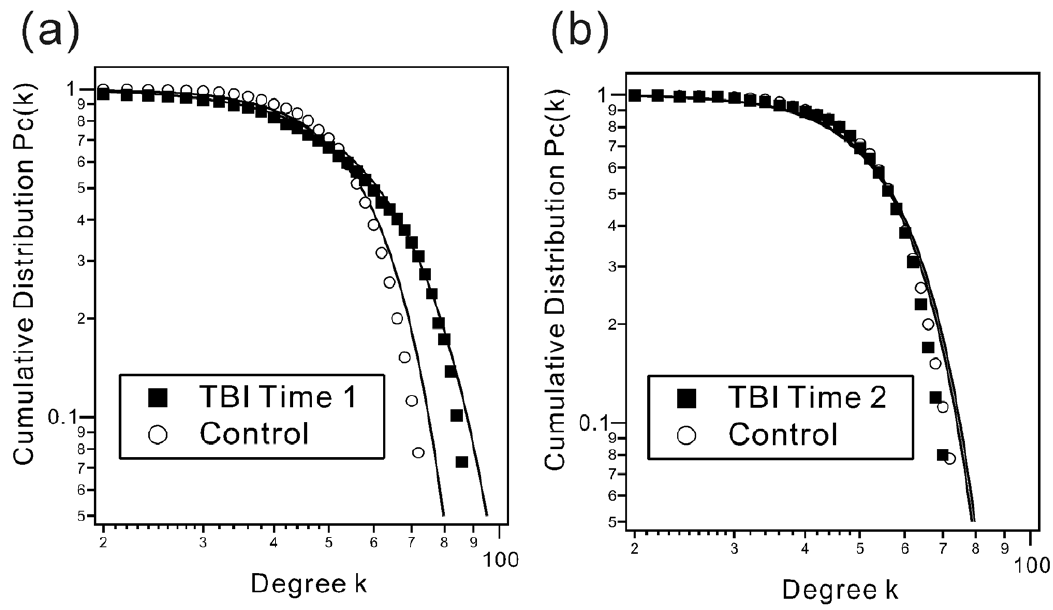
Figure 5. Cumulative degree distributions. The group averaged cumulative degree distributions P c ( k ) from (a) TBI at Time 1 and (b) Time 2 on double logarithmic scale. The solid curves are the best fitting stretched exponential function P c ( k ) * exp( { a k b ) to the averaged cumulative degree distributions ranging from degree k =30 to 80. The value of fitting parameter b was 3.65 6 0.41 for TBI at Time 1 and 4.58 6 0.18 for Time 2, respectively. For Control group, the value of b was 4.78 6